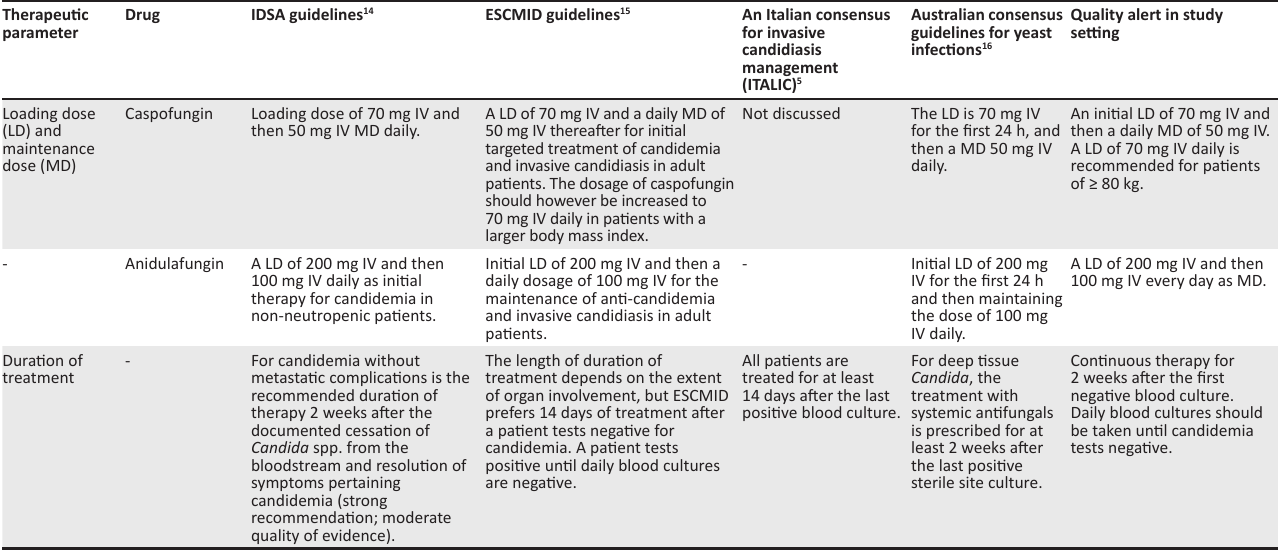
TABLE 3: The different international guidelines and local Quality Alert pertaining the loading dose and prescribing daily dose for the prescribing of echinocandins. Therapeutic